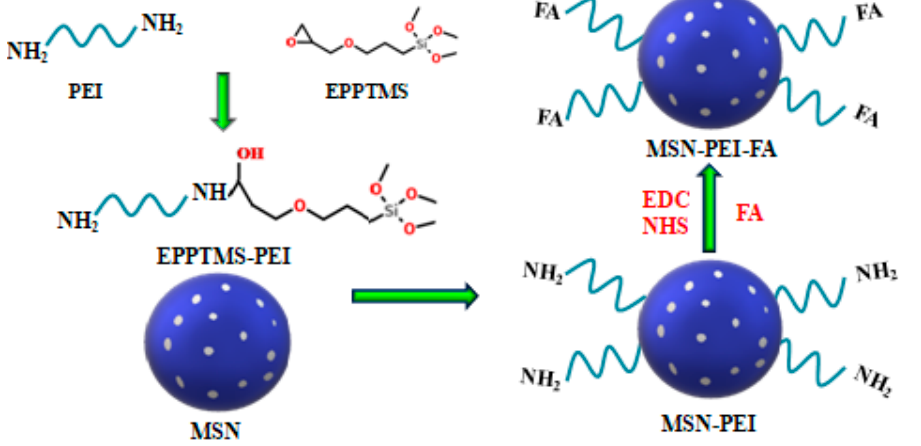
Figure 1. The preparation route and schematic diagram of mesoporous silica nanoparticles- polyethyleneimine-folic acid